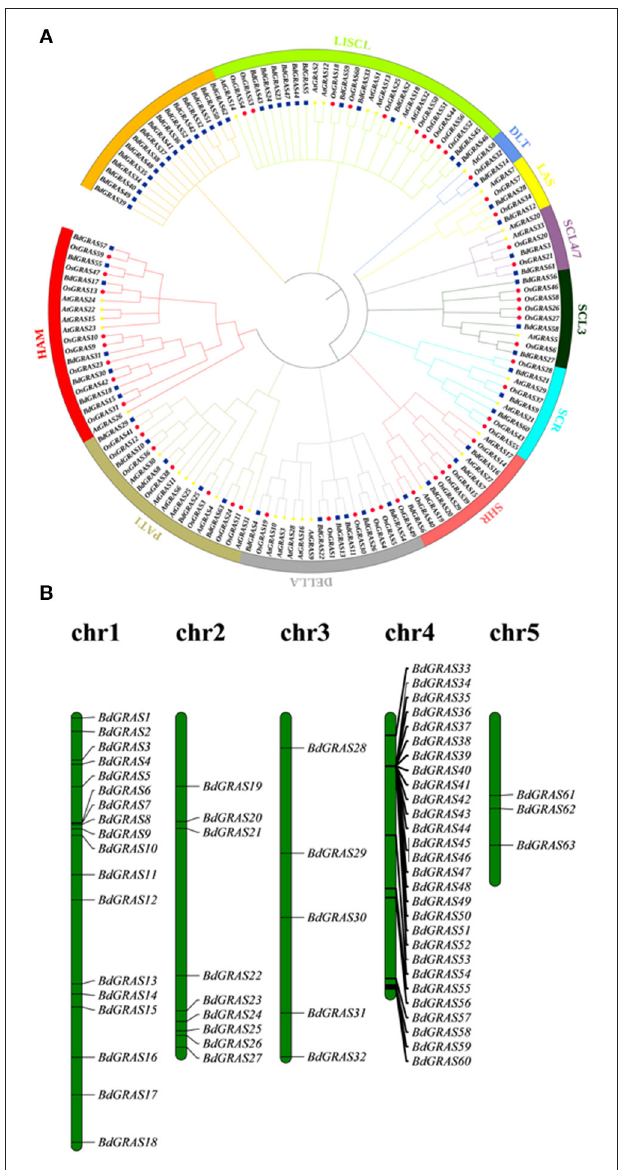
FIGURE 1 | Phylogenetic analysis of GRAS proteins in Arabidopsis thaliana , Oryza sativa and Brachypodium distachyon and chromosomal mapping of GRAS gene in Brachypodium distachyon. (A) The phylogenetic tree is divided into 10 different subfamilies, and the different subfamilies are shown with branches and outer ring of different colors. The blue solid square represents B. distachyon GRAS protein, the red solid circle represents O. sativa protein, and the yellow five-pointed star represents Arabidopsis protein. (B) Chromosomal locations of GRAS genes in B. distachyon .